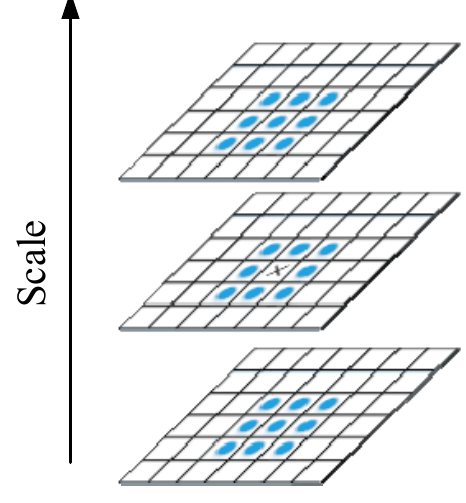
Figure 8. Interest point localization.